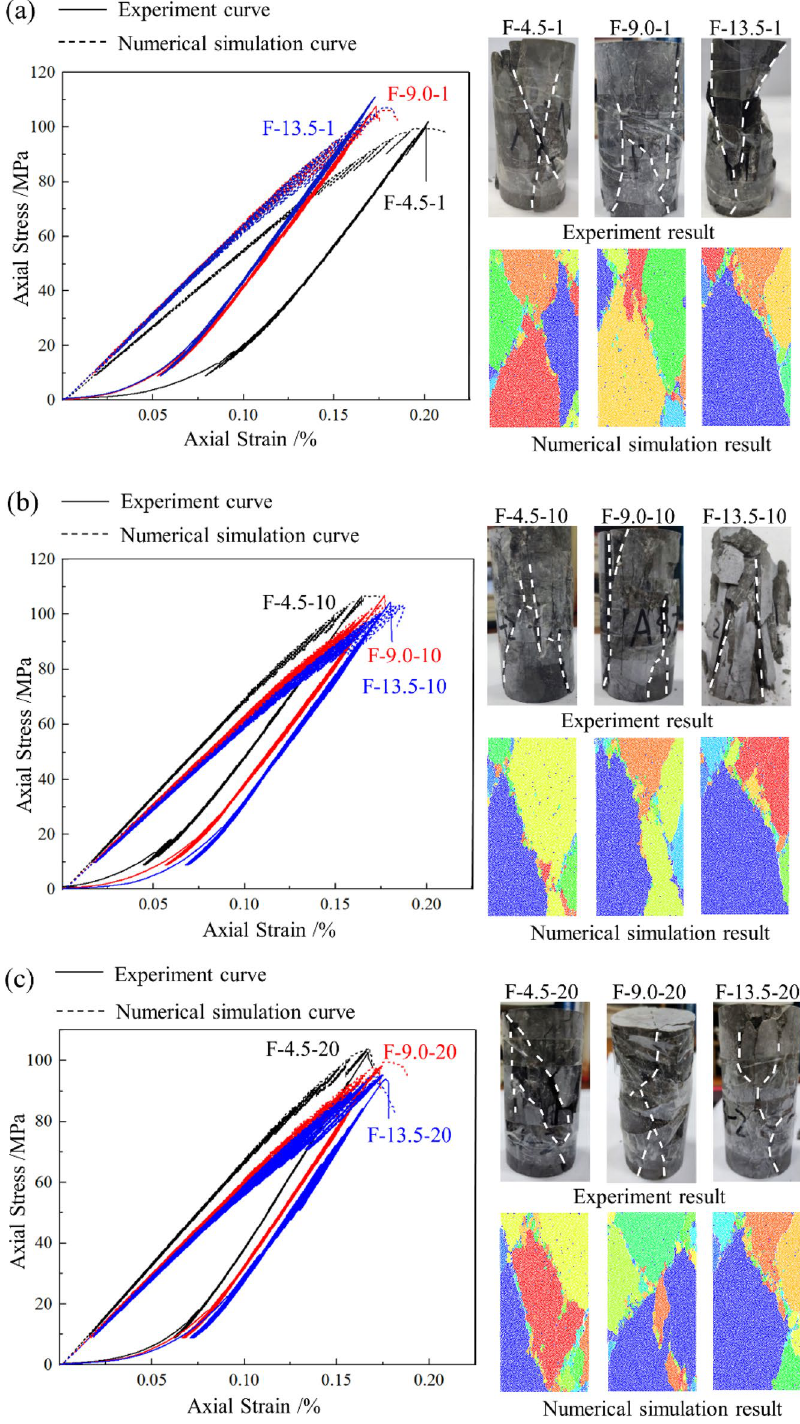
Figure 7. Experiment and simulation results of multi-level cyclic loading test. ( a ) N = 1; ( b ) N = 10; ( c ) N =